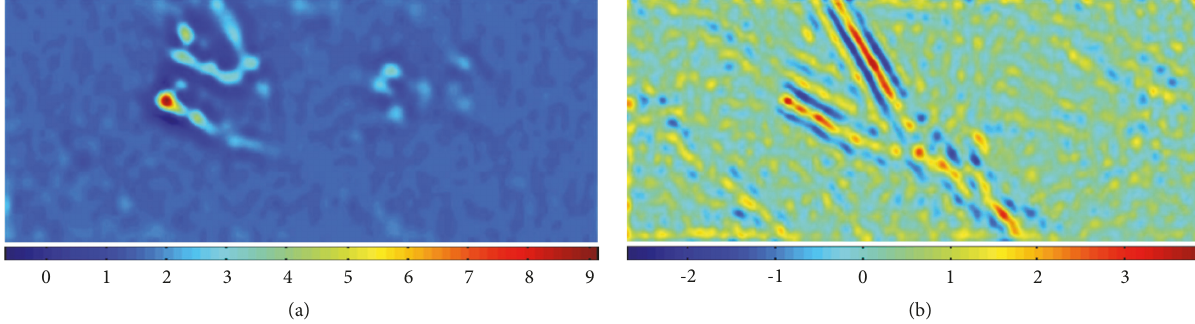
Figure 6: Decomposition results of the 40th subimage obtained using MCA. (a) The cartoon layer obtained using the MCA algorithm. (b) The texture layer obtained using the MCA algorithm.